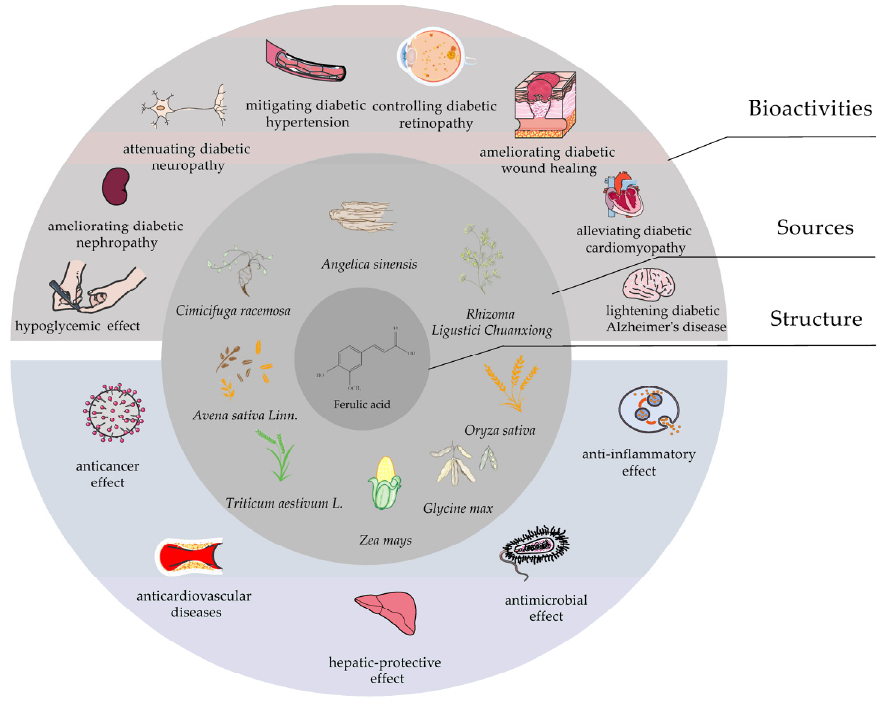
Figure 2. Structure, sources and bioactivities of ferulic acid.